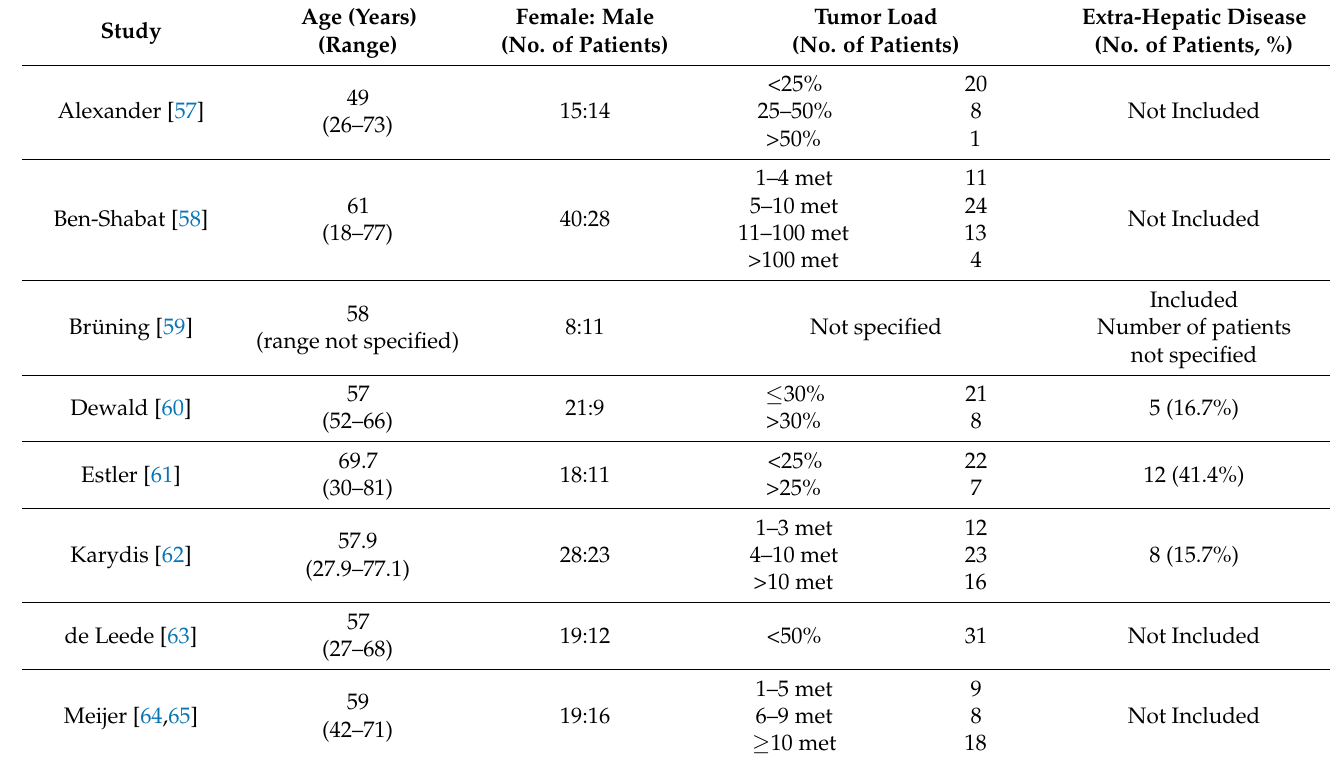
Table 2. Patient